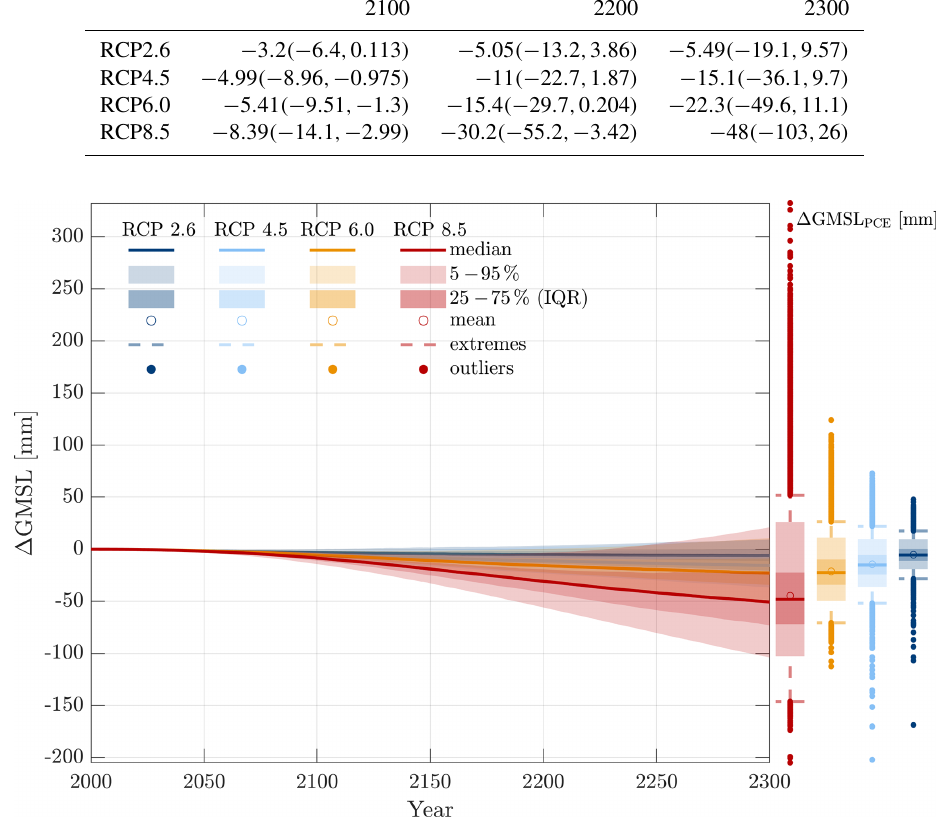
Figure 6. Projections of changes in global mean sea level ( (cid:49) GMSL) from 2000 and 2300 from our training ensemble of ice flow model simulations. Dark shading is the interquartile range (IQR) defined between the 25th and 75th percentiles. Lighter shading shows the 5th–95th percentiles. Box plots show the projections from the surrogate models ( (cid:49) GMSL PCE ) for each RCP scenario at 2300. Extreme values are located at 1.5 times the interquartile range away from the 25th and 75th percentiles. Values outside of these extreme bounds are considered to be